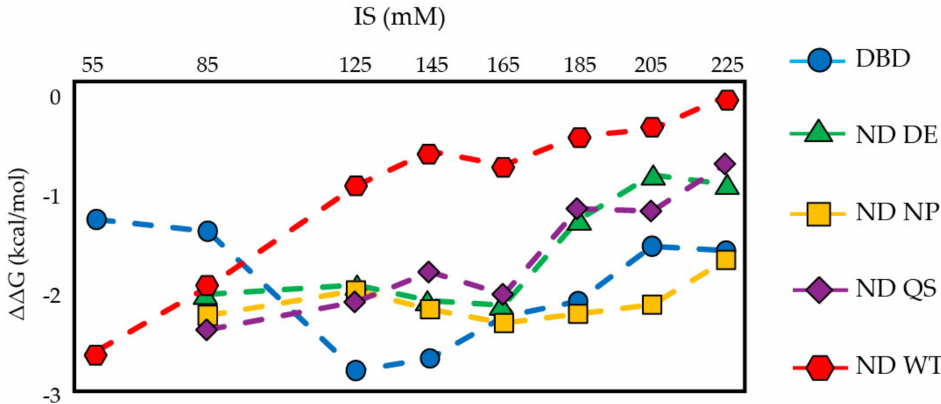
Figure 4. Binding specificity of DBD, ND WT, and ND mutants. For each p53 fragment, ∆∆ G = ∆ G ∆ G consensus − scrambled at a given IS indicates binding